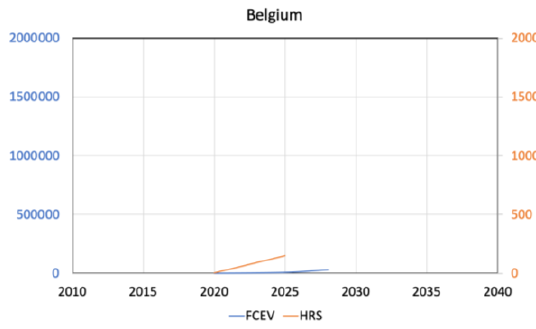
Fig. 1. The number of HRS and FCEVs in Belgium